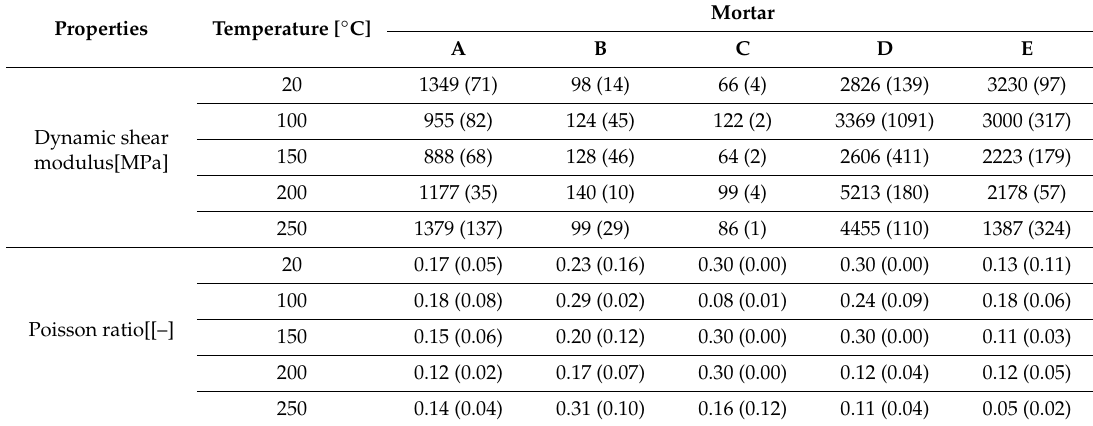
Table 5. Summary of dynamic shear modulus and Poisson ratio: average and standard deviation (in parentheses).